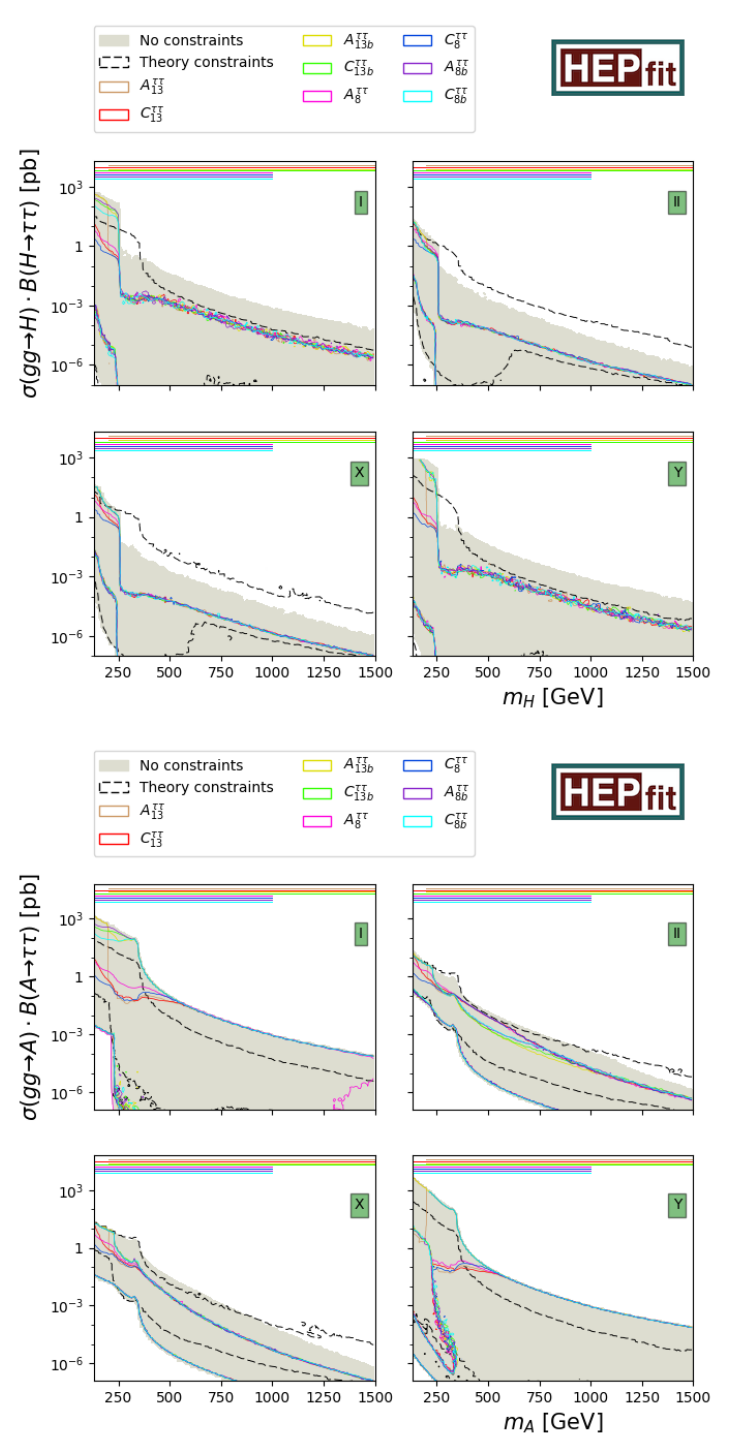
Figure 7 . 95% contours of the single searches for H=A ! (cid:28)(cid:28) in the (cid:27) (cid:1) B vs. m four 2HDM types (top: H , bottom: A ). For details, see text.